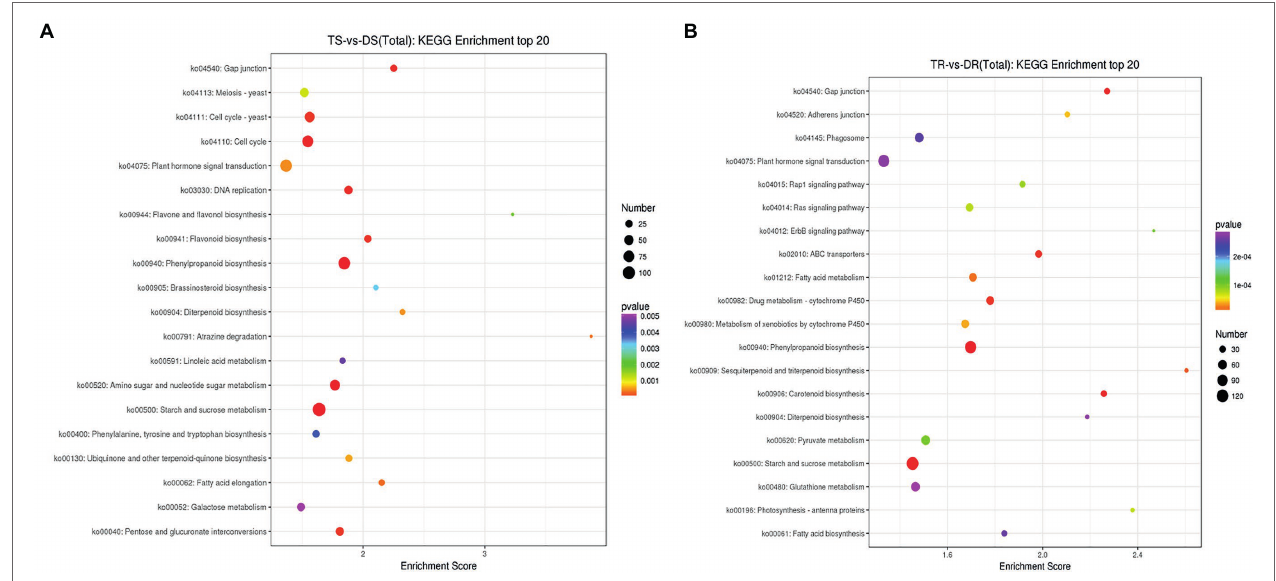
FIGURE 6 | Map of KEGG enrichment analysis results for DEGs. (A) TS vs. DS; (B) TR vs.